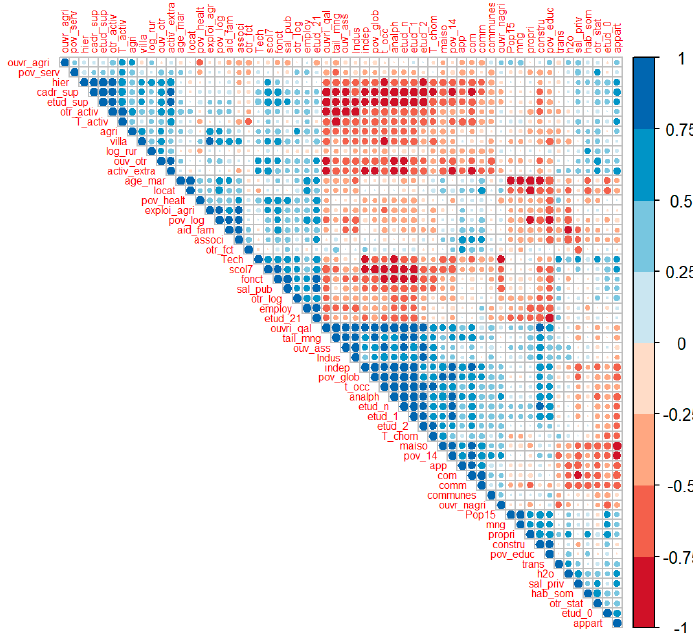
Figure 4. Correlation matrix.